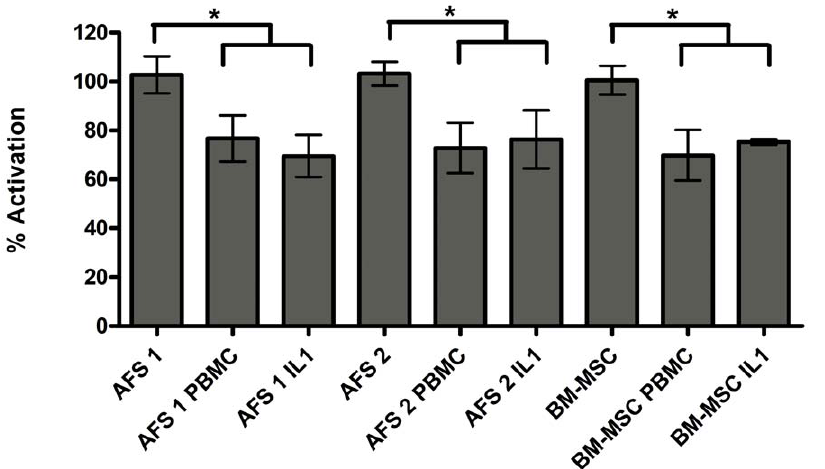
Figure 3. AFS mediated immunosuppression does not require cell-cell contact. Amniotic fluid stem (AFS) cells from two independent sources or bone marrow derived mesenchymal stem cells (BM-MSCs) were cultured under growth conditions (AFS 1, AFS 2, BM-MSC) or activated by co-culture with total blood monocytes (AFS 1 PBMC, AFS 2 PBMC, BM-MSC PBMC) or IL-1 b (AFS 1 IL1, AFS 2 IL1, BM-MSC IL1) to release soluble factors. One way mixed lymphocyte reactions (MLR) were incubated in the presence of 24 hour conditioned medium from stem cells cultured with either peripheral blood mononuclear cells (PBMCs) or IL-1 b . PHA activated lymphocytes were cultured in 96 well plates coated with IFN- c capture antibody in the presence of conditioned mediums for 24 hours. Positive control wells contained lymphocytes activated with PHA and negative control wells contained unactivated lymphocytes. Lymphocyte activation was assessed by counting the number of clones producing IFN- c . Percent activation was calculated by comparing wells containing stem cells to positive control wells. It can be seen that all supernatants were capable of inhibiting T-cell activation by PHA by approximately 20–25%. All conditions are statistically significant when compared to the positive control wells.